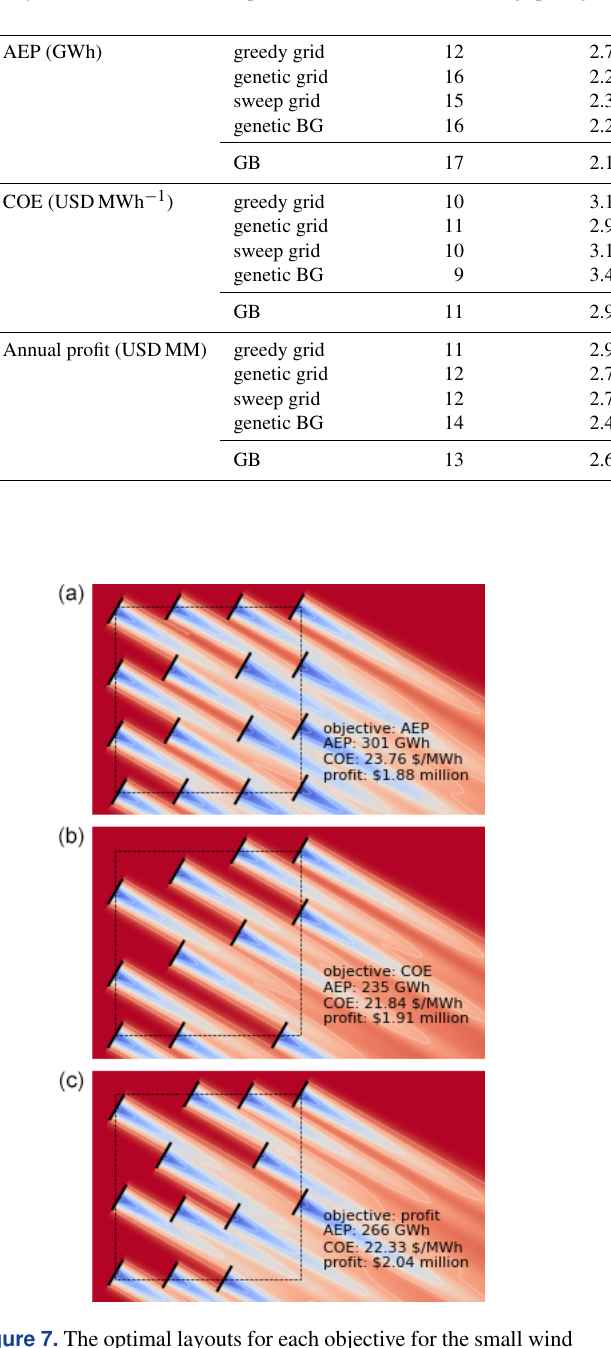
Figure 7. The optimal layouts for each objective for the small wind power plant with a unidirectional wind rose. From top to bottom, the associated objective functions are AEP, COE, and profit. The text within each figure provides the values for all three metrics for each wind